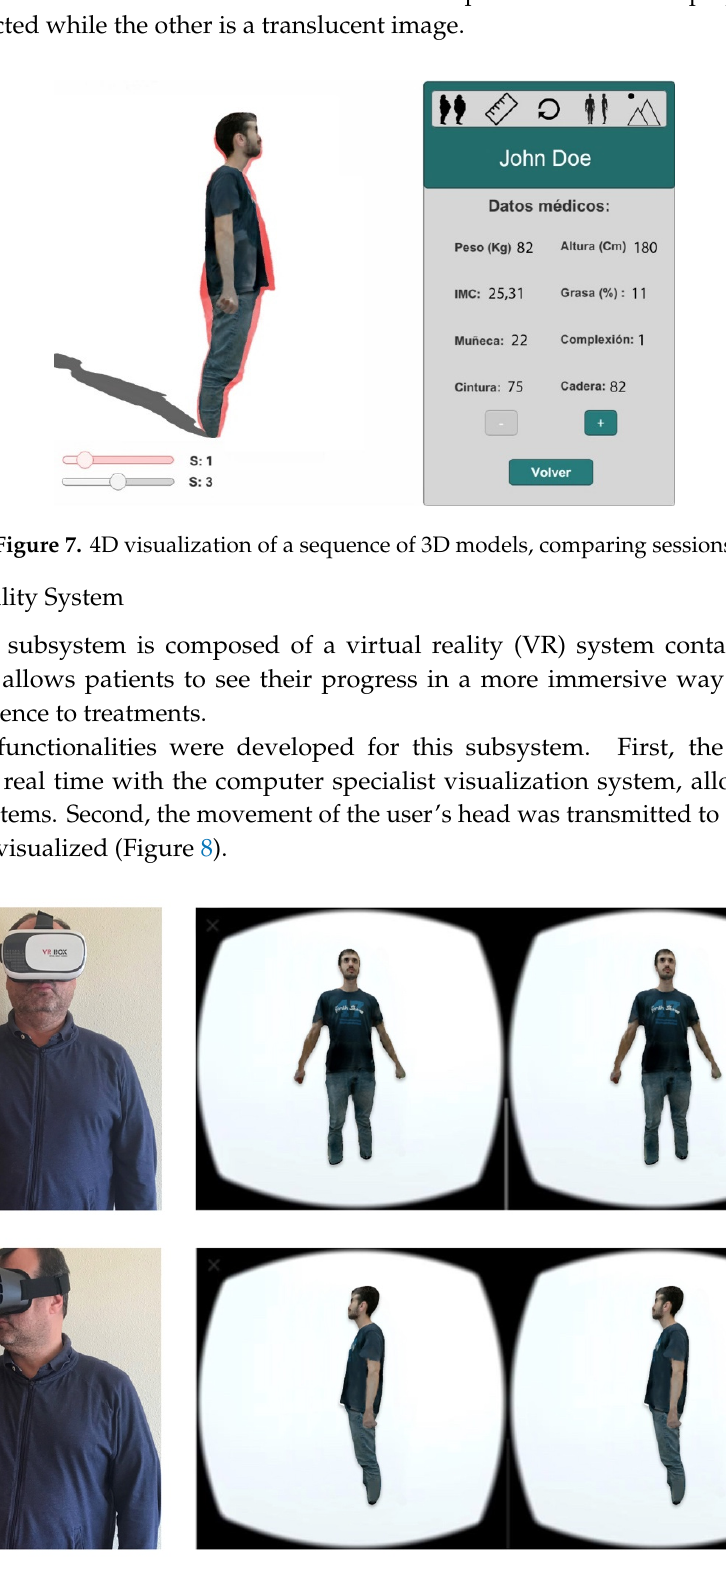
Figure 8. Transmission of motion to the 3D model with head positions (left) and rotated stereo images (right) .